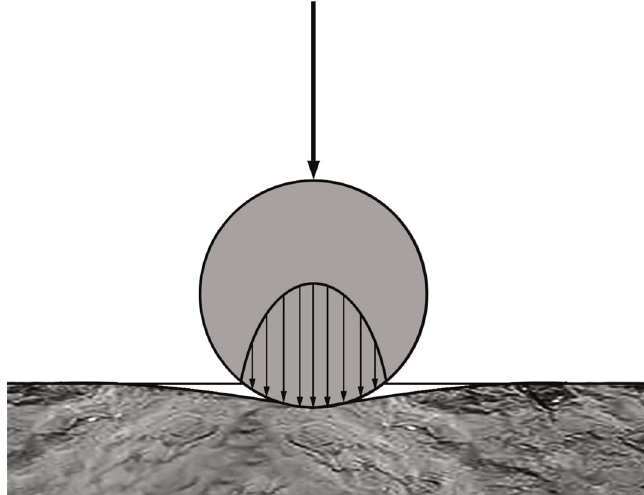
Figure 1: Force diagram of composite plate.